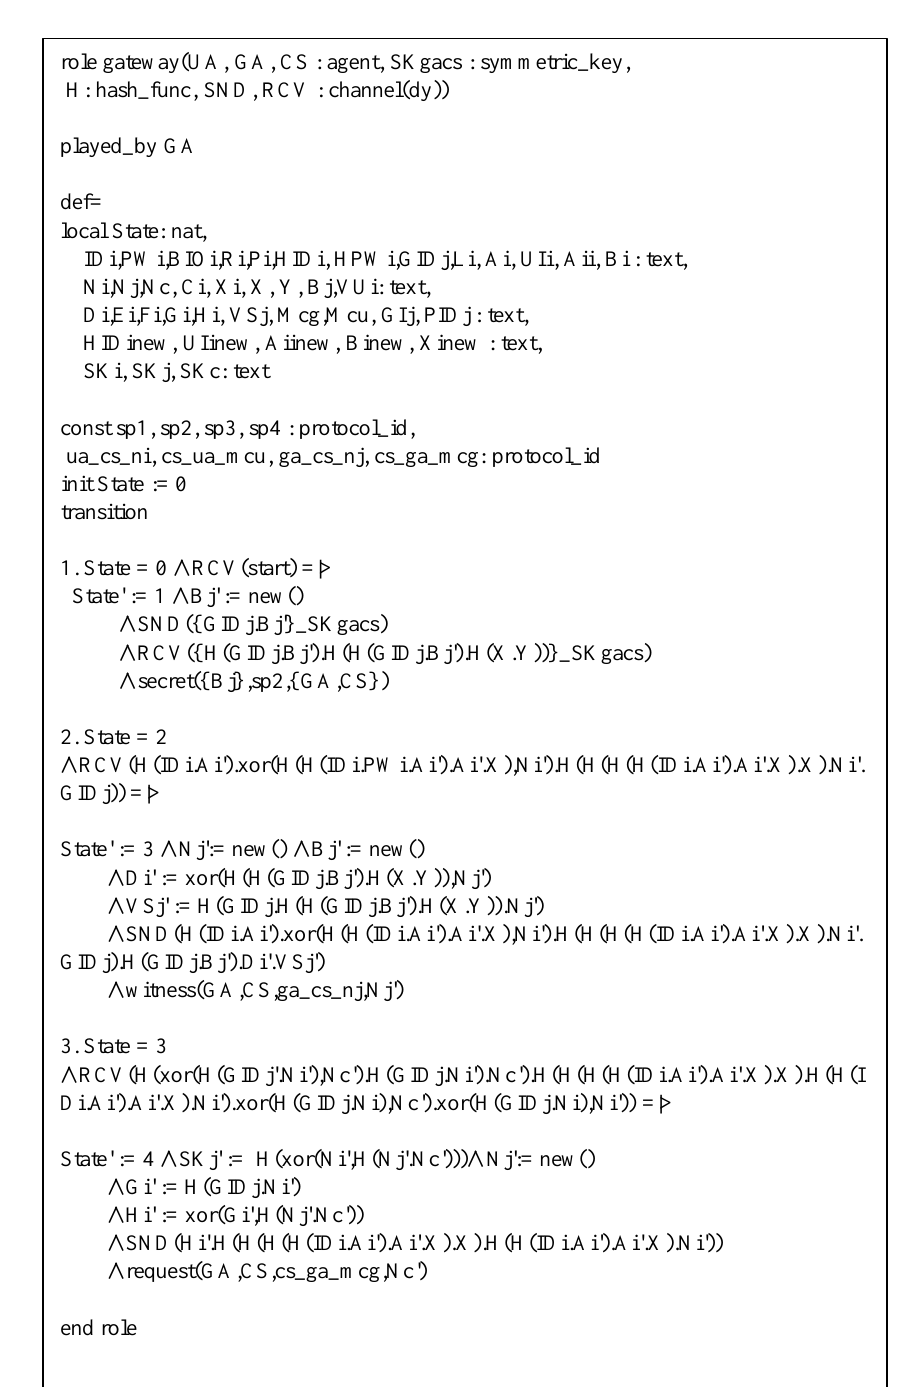
Figure 10. Specification of